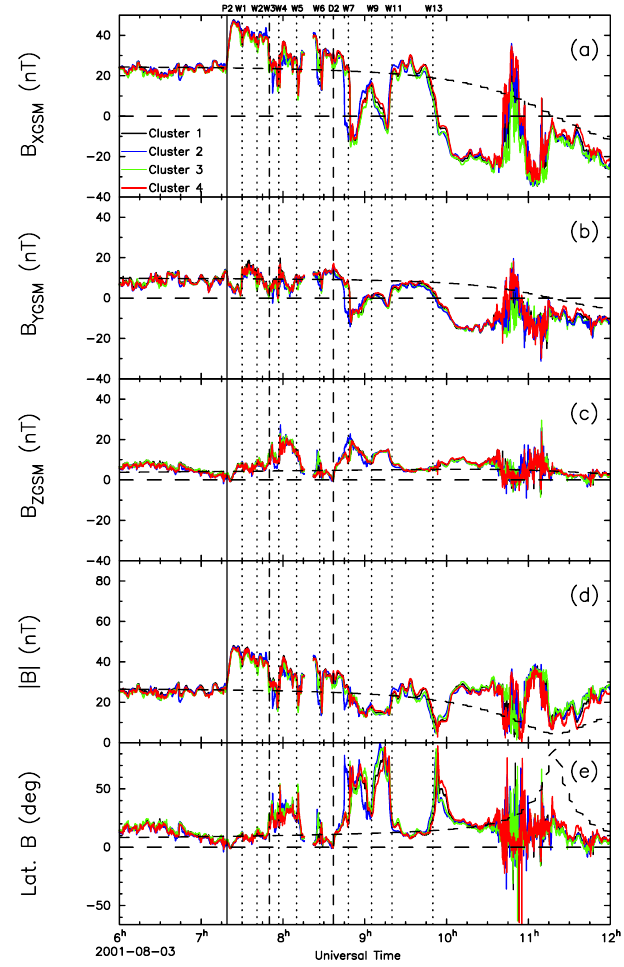
Fig. 8. Plot of FGM data Cluster. Panels (a–c) show the B X , B Y and B Z magnetic field components in GSM coordinates. Panel (d) shows the magnetic field magnitude. Panel (e) shows the magnetic field latitude angle. The black dashed traces are the model field components from the T89 model based on the centre of the Cluster tetrahedron. The solid vertical line indicates the effects of the solar wind pressure pulse. The dotted lines indicate the current sheet waves. The dashed lines indicate the times of the dipolariza- tions of the